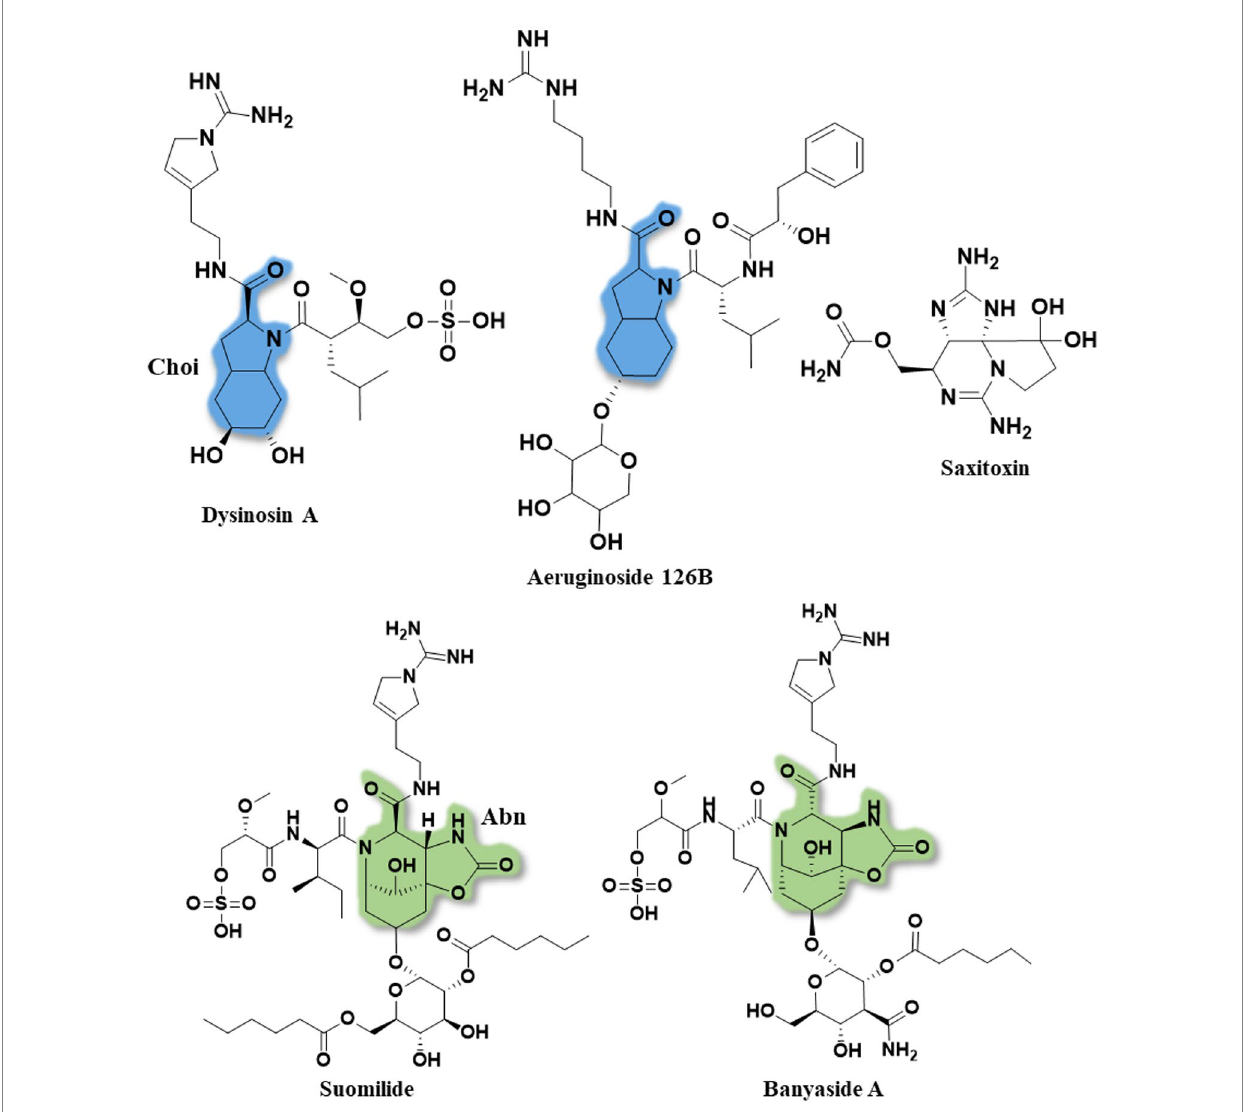
FIGURE 2 The full structures of dysinosin A, aeruginoside 126B, saxitoxin, suomilide ( 7 ) and banyaside A ( 5 ). The 2-carboxyl-6-hydroxyoctahydroindole (Choi) is marked in blue and the azabicyclononane (Abn) is highlighted in green. Note the structural similarities between the cyanobacterial metabolites, consisting of a bi-, or tri-cyclic core unit decorated with Aeap or 2-O-methylglyceric acid 3-O-sulfate